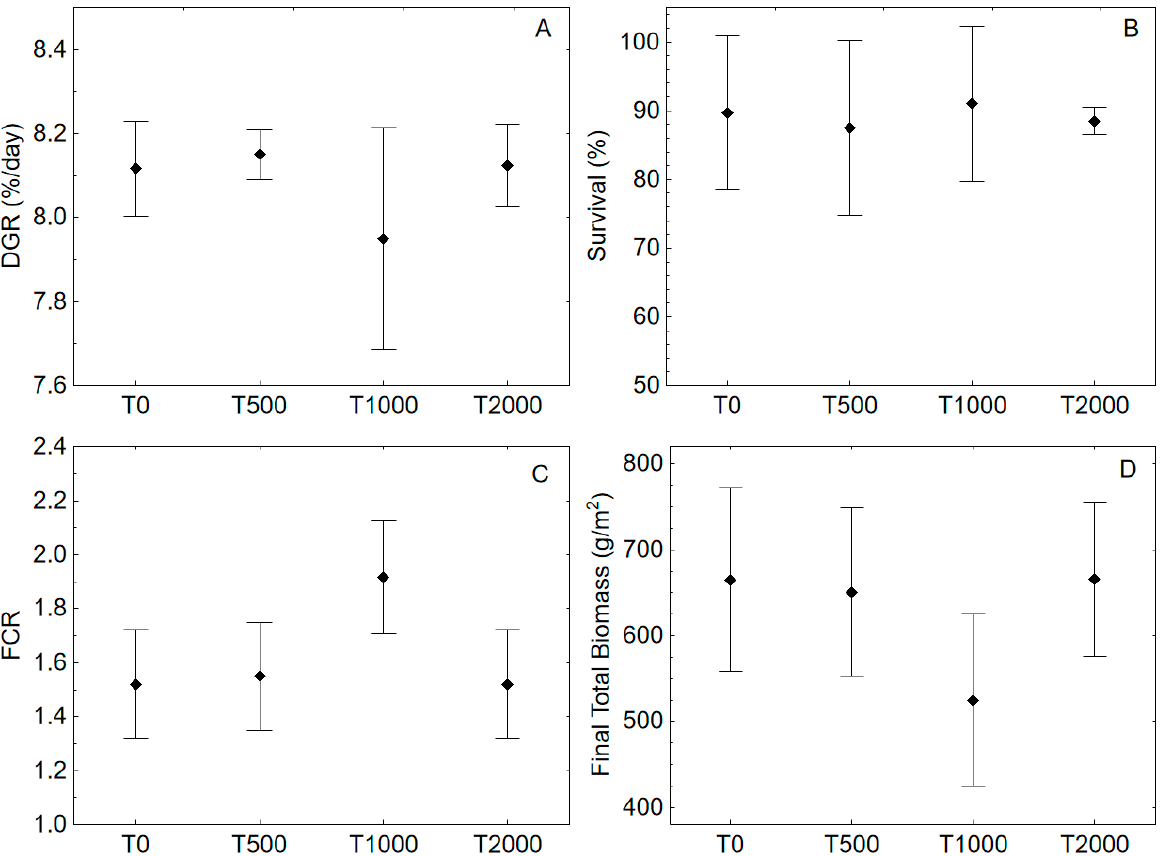
Figure 1. Mean (±SD) of daily growth rate—DGR ( A ), survival ( B ), feed conversion ratio—FCR ( C ), and final total biomass ( D ) of L. vannamei . T0: shrimp monoculture (100 shrimp/m 2 ); T500: 100 shrimp/m 2 and 500 g/m 2 of G. birdiae ; T1000: 100 shrimp/m 2 and 1000 g/m 2 of G. birdiae ; T2000: 100 shrimp/m 2 and 2000 g/m 2 of G. birdiae . No significant differences were found according to ANOVA followed by the Tukey test ( p > 0.05).